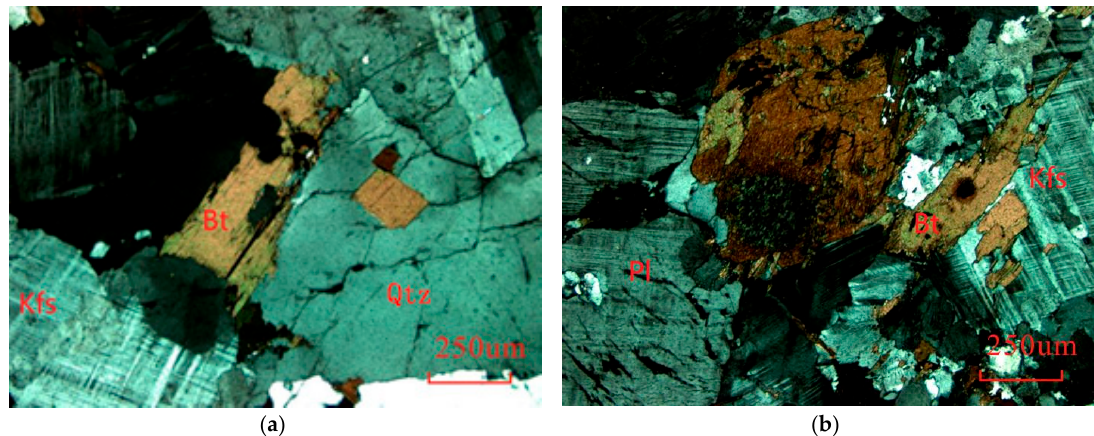
Figure 1. The location of the Alashan area and a photo of rock cores deeply drilled for test specimens.